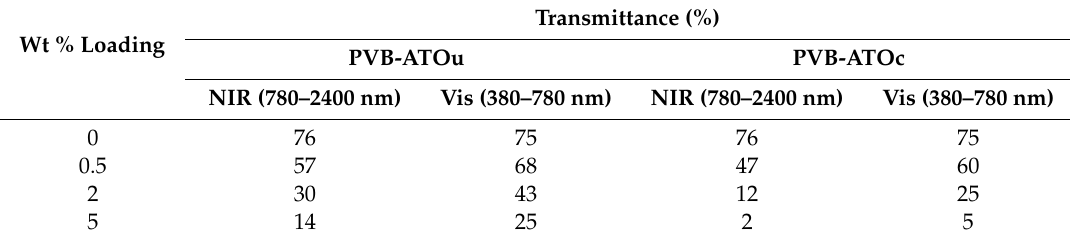
Table 2. Transmittance values of PVB and PVB-ATO films averaged over the wavelength range of visible and near infrared light.